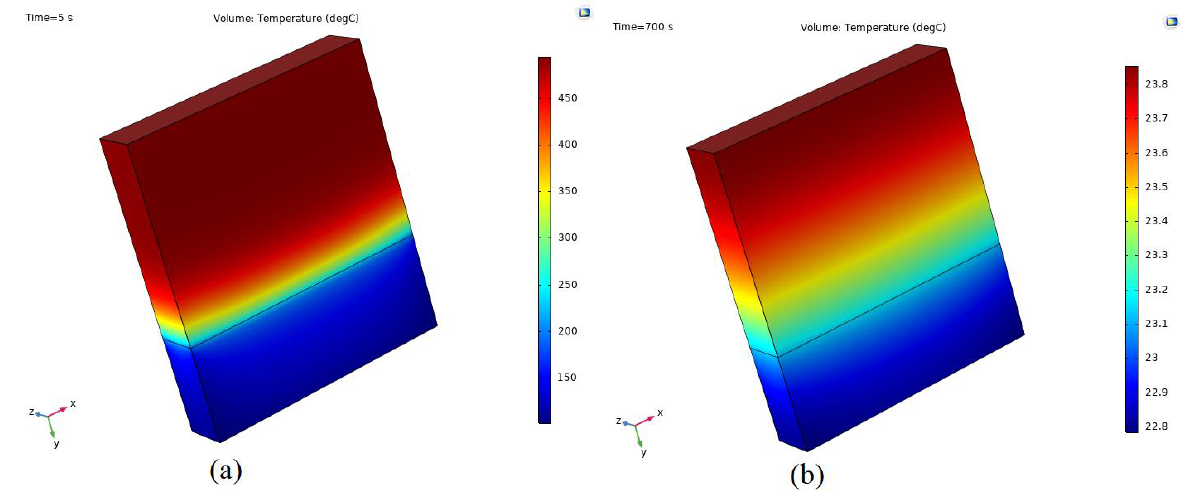
Figure 5. The FEA results for the quenching of the block at ( a ) 5 s and ( b ) 700 s.